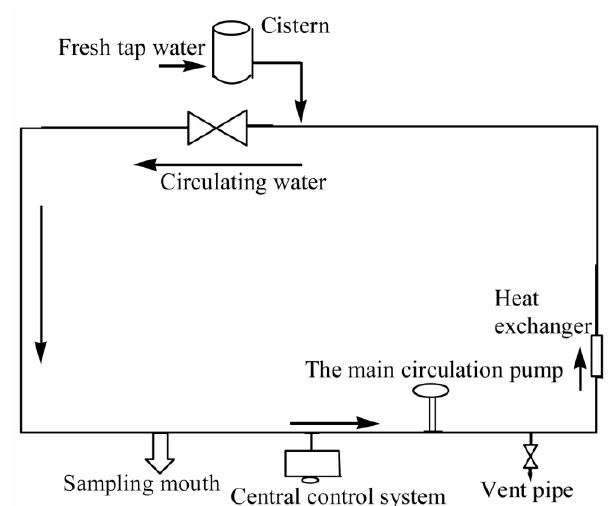
Figure 1. Experimental device for the water distribution system.